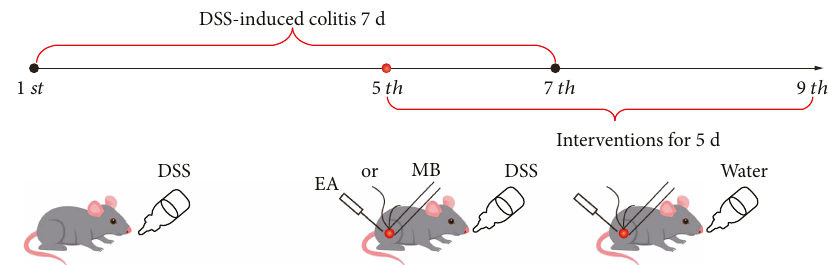
Figure 1: Schematic diagram illustrating the major steps of the experimental procedure in the dextran sodium sulfate- (DSS-) induced colitis model and EA or MB inventions. The MD, EA, and MB mice were induced to the ulcerative colitis model by drinking 2.5% DSS for 7 d. After establishment of the model on the 5 th day, the EA and MB groups were treated by electroacupuncture or moxibustion, respectively, for 5 d. NG: normal group; MD: model group; EA: electroacupuncture group; MB: moxibustion